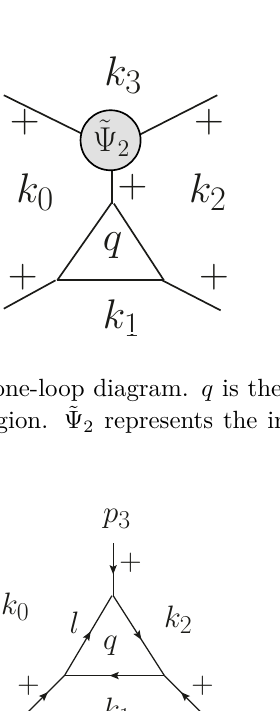
with the external region. l is the loop momentum and p i